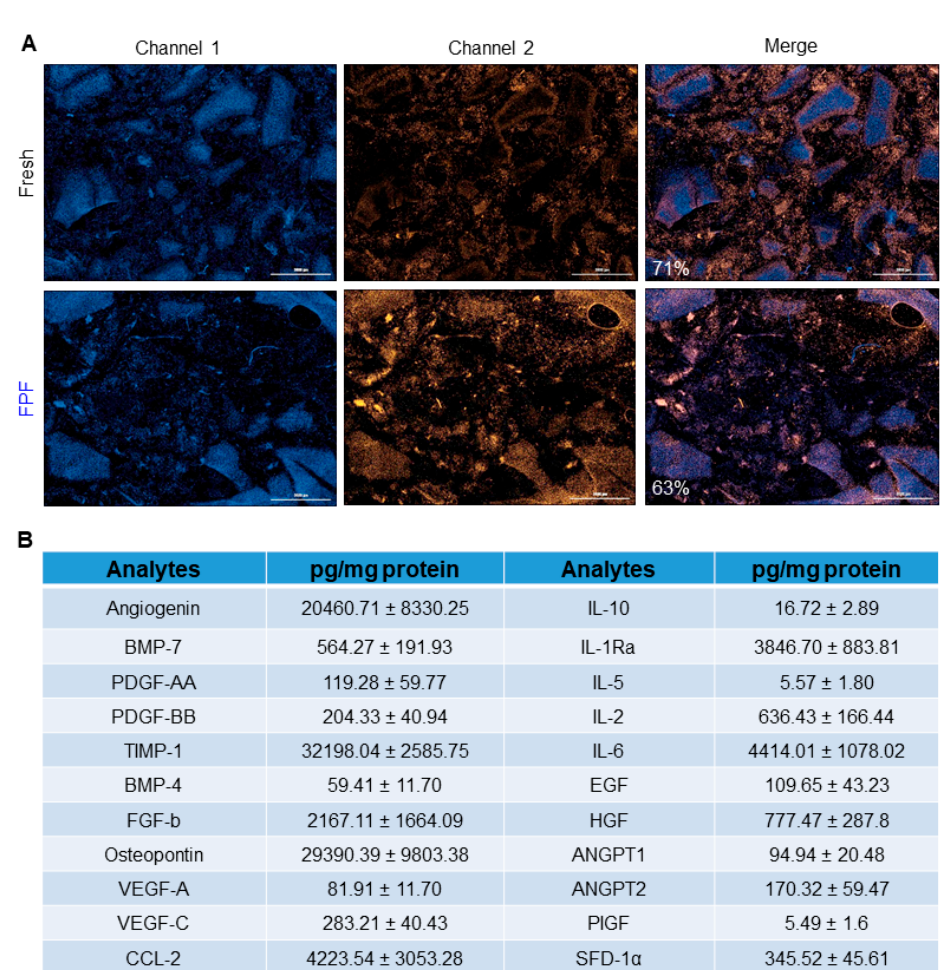
Figure 1. FPF retains viable endogenous cells and beneficial factors. ( A ) Cell viability, as determined by LIVE / DEAD staining, of fresh ( top panel ) and cryopreserved ( bottom panel ) FPF. Dead cells were visualized by SYTOX orange stain, while cell nuclei were stained with Hoechst 33342. Representative images for 1 out of 5 tested donors show a comparable number of viable cells for both conditions. Scale bars = 3000 µ m (B ) Levels of growth factors in cryopreserved FPF as determined by luminex and expressed in pg / mg protein. Detectable growth factors are as follows: angiogenin, bone morphogenetic protein (BMP-7, -4), platelet-derived growth factor (PDGF- AA, -BB), tissue inhibitor of matrix metalloproteinases-1 (TIMP-1), basic fibroblast growth factor (FGF-b), osteopontin, vascular endothelial growth factor (VEGF-A, -C), C-C motif chemokine ligand 2 (CCL-2), interleukin (IL-10, -2, -6, -5), interleukin-1 receptor antagonist (IL-1Ra), epidermal growth factor (EGF), hepatocyte growth factor (HGF), angiopoietin 1 (ANGPT1,- 2), placenta growth factor (PIGF), and stromal cell-derived factor-1 α (SDF-1 α ). Values represent mean ± SD (N =